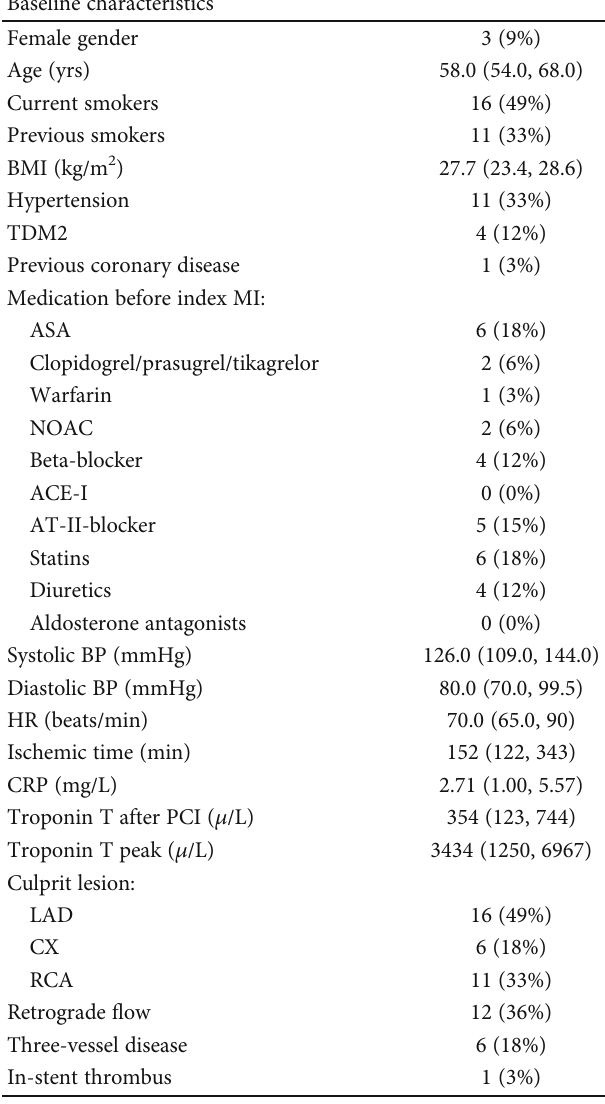
Table 1: Baseline characteristics. Baseline characteristics of the population ( n = 33 ). Values are given as absolute numbers (%) or medians (25, 75